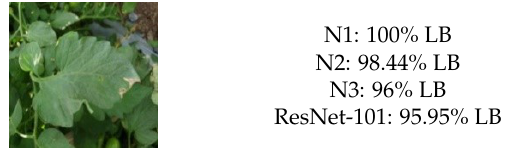
Figure 16. Predictions by N1, N2, N3, and ResNet-101 for KVKN